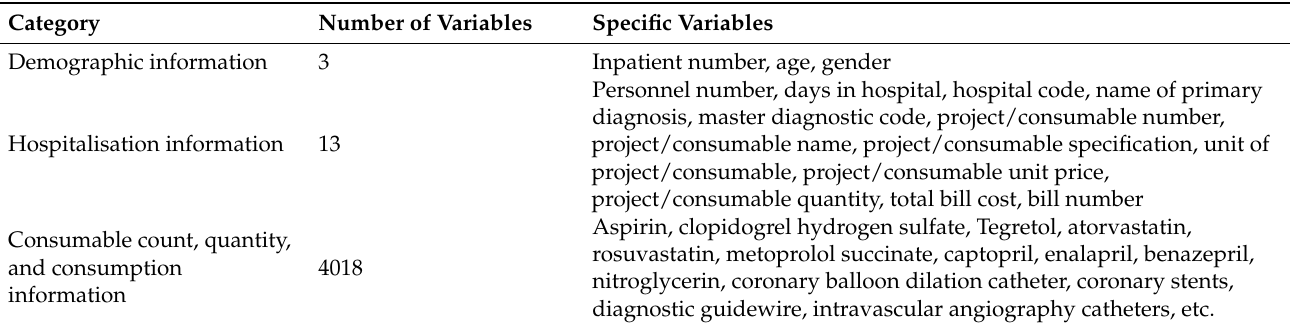
Table 2. Study’s raw data.